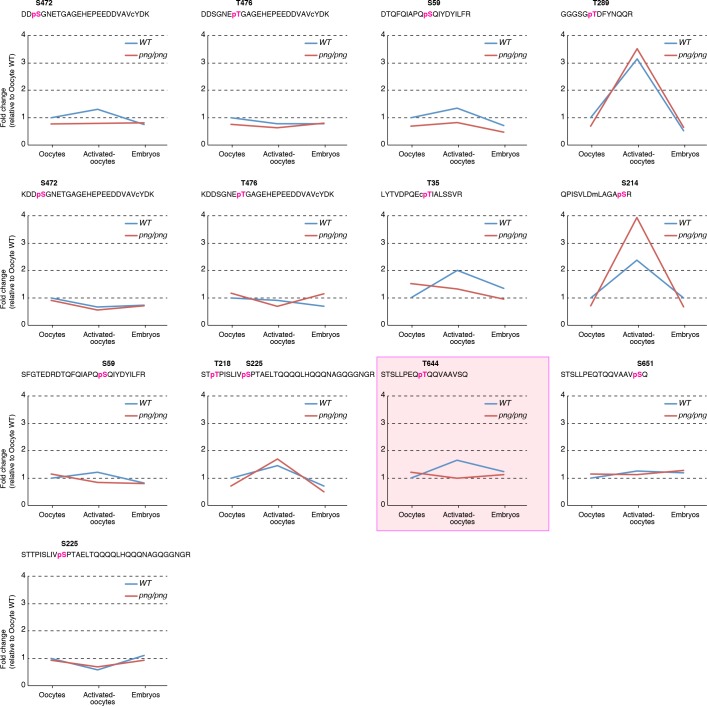
TRAL phosphorylation analysis by quantitative mass spectrometry.TRAL was immunoprecipitated from extracts of oocytes, in vitro activated oocytes and embryos of OrR (WT, blue line) or png1058/png1058 (png/png, red line). The precipitated TRAL proteins were analyzed by mass spectrometry. Identified phosphopeptides were manually validated. Threonine 644 is one of the phosphorylation sites identified in the biochemical PNG substrate screen (boxed in magenta). This was done one time. The Y-axes designate a relative value for peptide abundance.10.7554/eLife.33150.011Figure 3—figure supplement 1—source data 1.Quantification of phosphopeptide recovery.